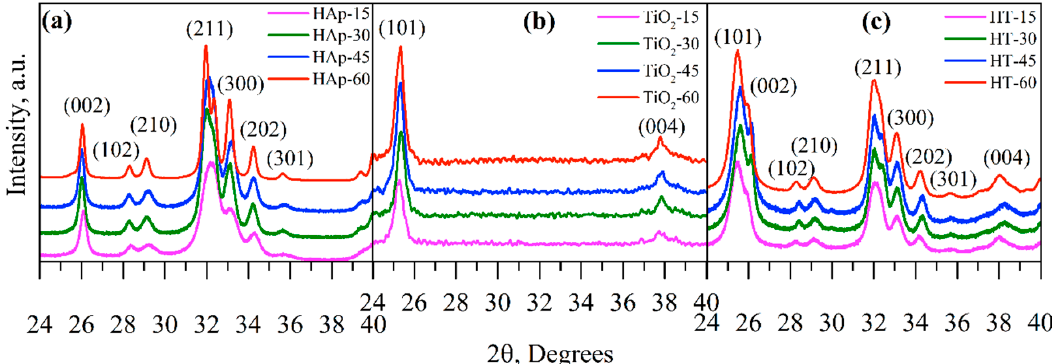
Figure 3. Characteristic diffraction peaks of the ( a ) HAp monoclinic and hexagonal phases ( b ) TiO 2 anatase phase, and ( c ) HT monoclinic, hexagonal and anatase phases.